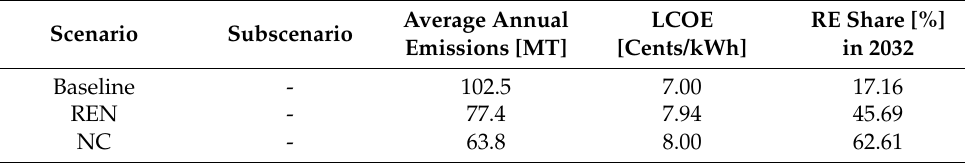
Table 19. Sensitivity analysis of emission reduction targets.